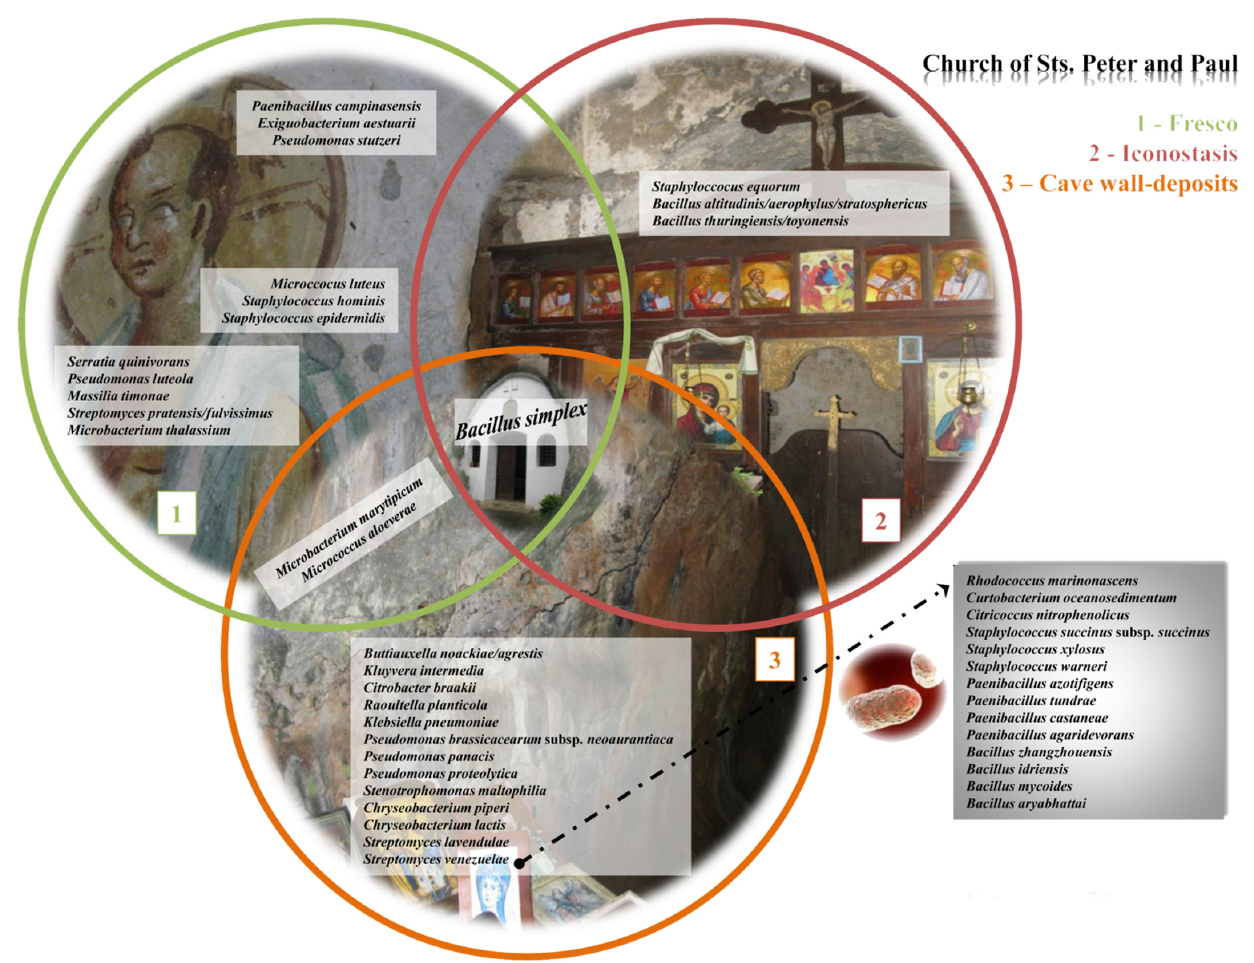
Figure 7. Spatial distribution of culturable bacterial isolates depending on the sampling site.